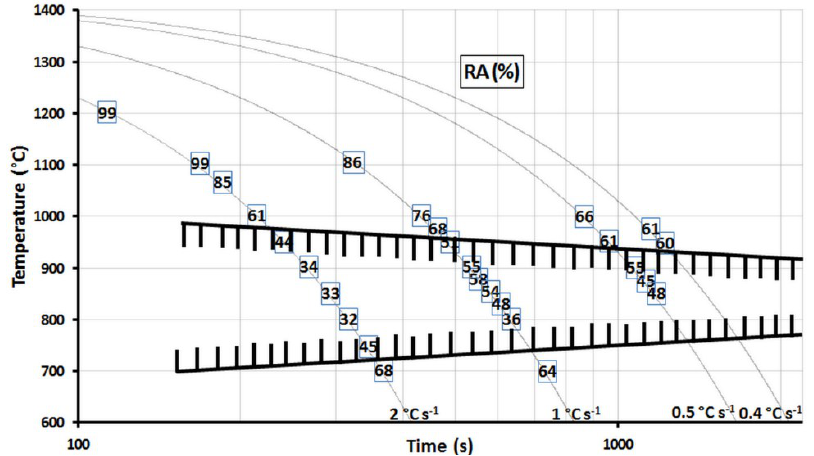
Figure 8. Continuous casting process (time-temperature-ductility) map of a peritectic steel for welded gas cylinders (έ = 0.1 s −1 ; shaded area shows poor ductility zone and figures on the cooling routes represent RA